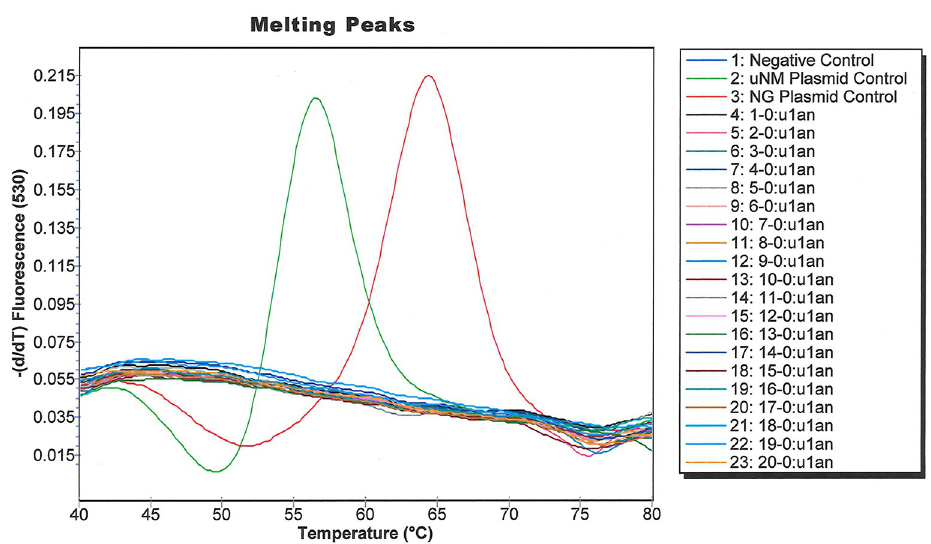
Fig 4. Amplification curves generated from specimens of the first 20 men in the IUMP cohort using the SimpleProbe 1 US_NmUC assay.